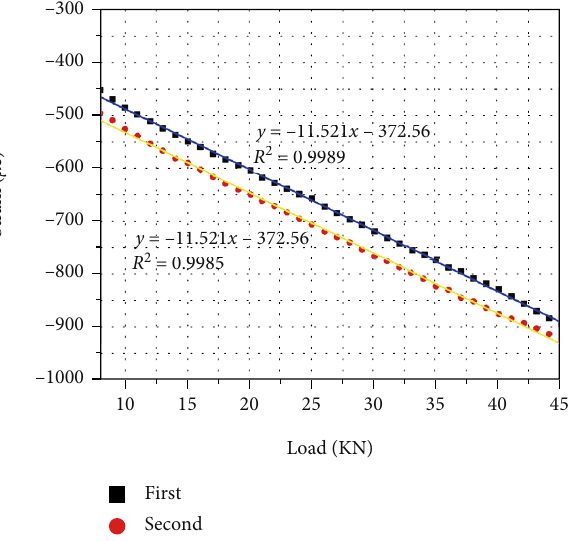
Figure 10: Linear fi tting of compressive strain and load.